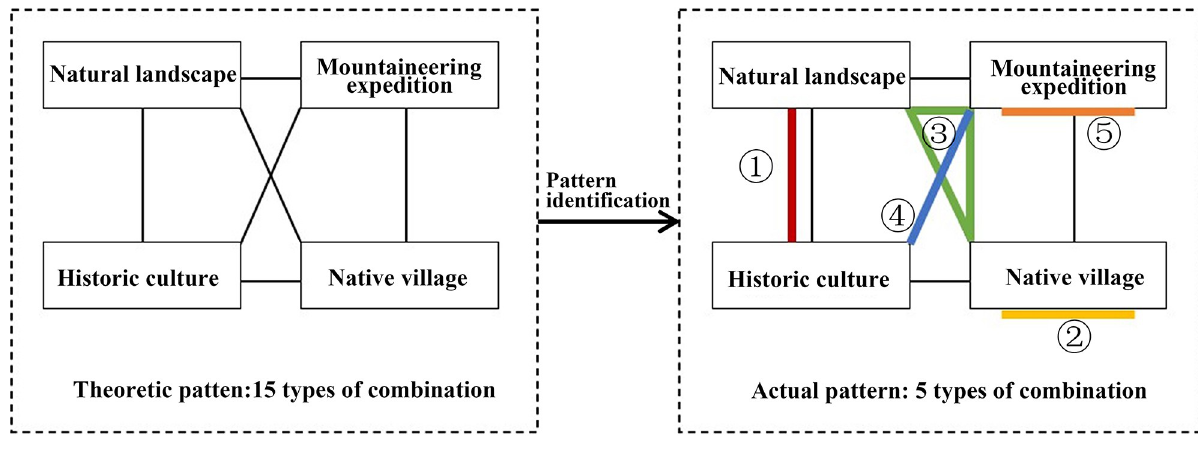
Fig 7. Theoretical and practical models of recreation